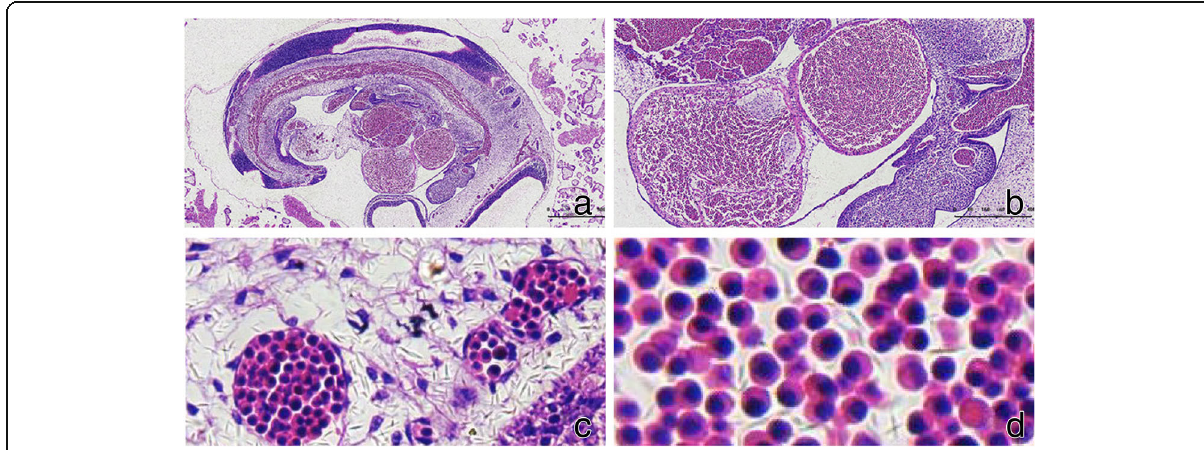
Fig. 1 Early embryonic tissue and its nucleated erythrocytes (H&E staining). a shows the embryonic tissue (10× magnification), b shows embryonic extramedullary hematopoiesis (100× magnification), c shows intravascular extramedullary hematopoiesis (200× magnification), and d shows nucleated erythrocytes (400×